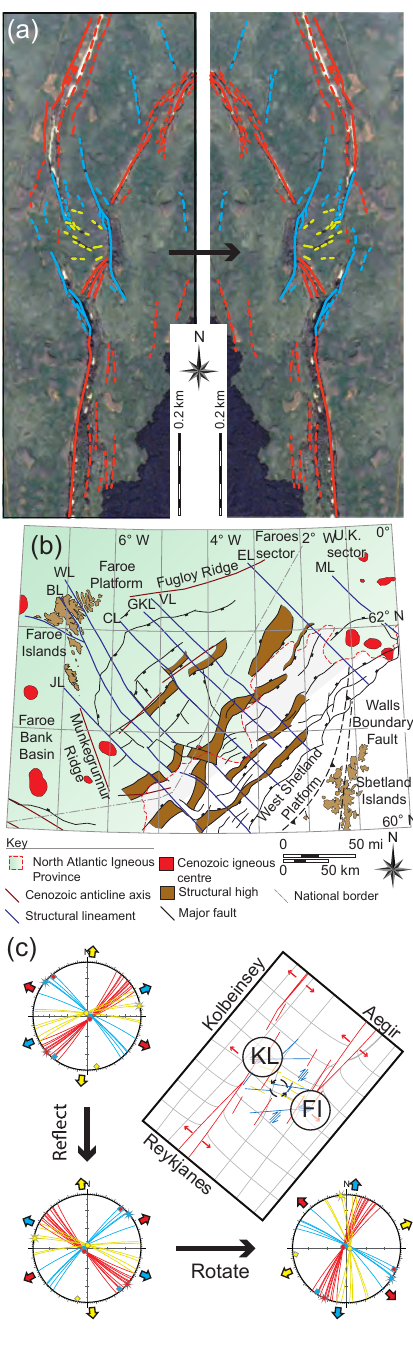
Figure 11. (a) Reflection of left-stepping Krafla faults to a right- stepping NE Atlantic rift configuration. (b) Map of the European margin of the NE Atlantic showing the broad NE–SW basin trend. JL: Judd Lineament; CL: Clare Lineament; GKL: Grimur Kamban Lineament; VL: Victory Lineament; EL: Erlend Lineament; ML: Møre Lineament; BL: Brynhild Lineament; WL: Westray Linea- ment. (c) Krafla faults are rotated into the orientation of the Atlantic European margin basin system and compared with the Reykjanes– Ægir